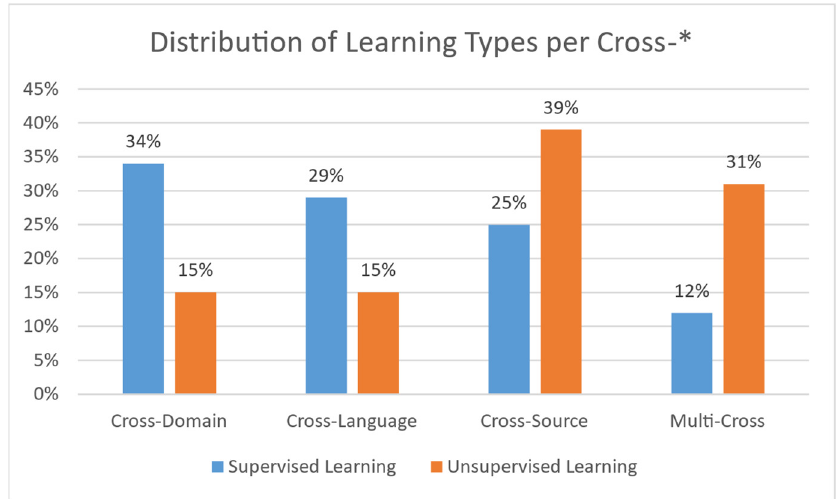
Figure 4. Distribution of learning techniques for Cross-* Detection.